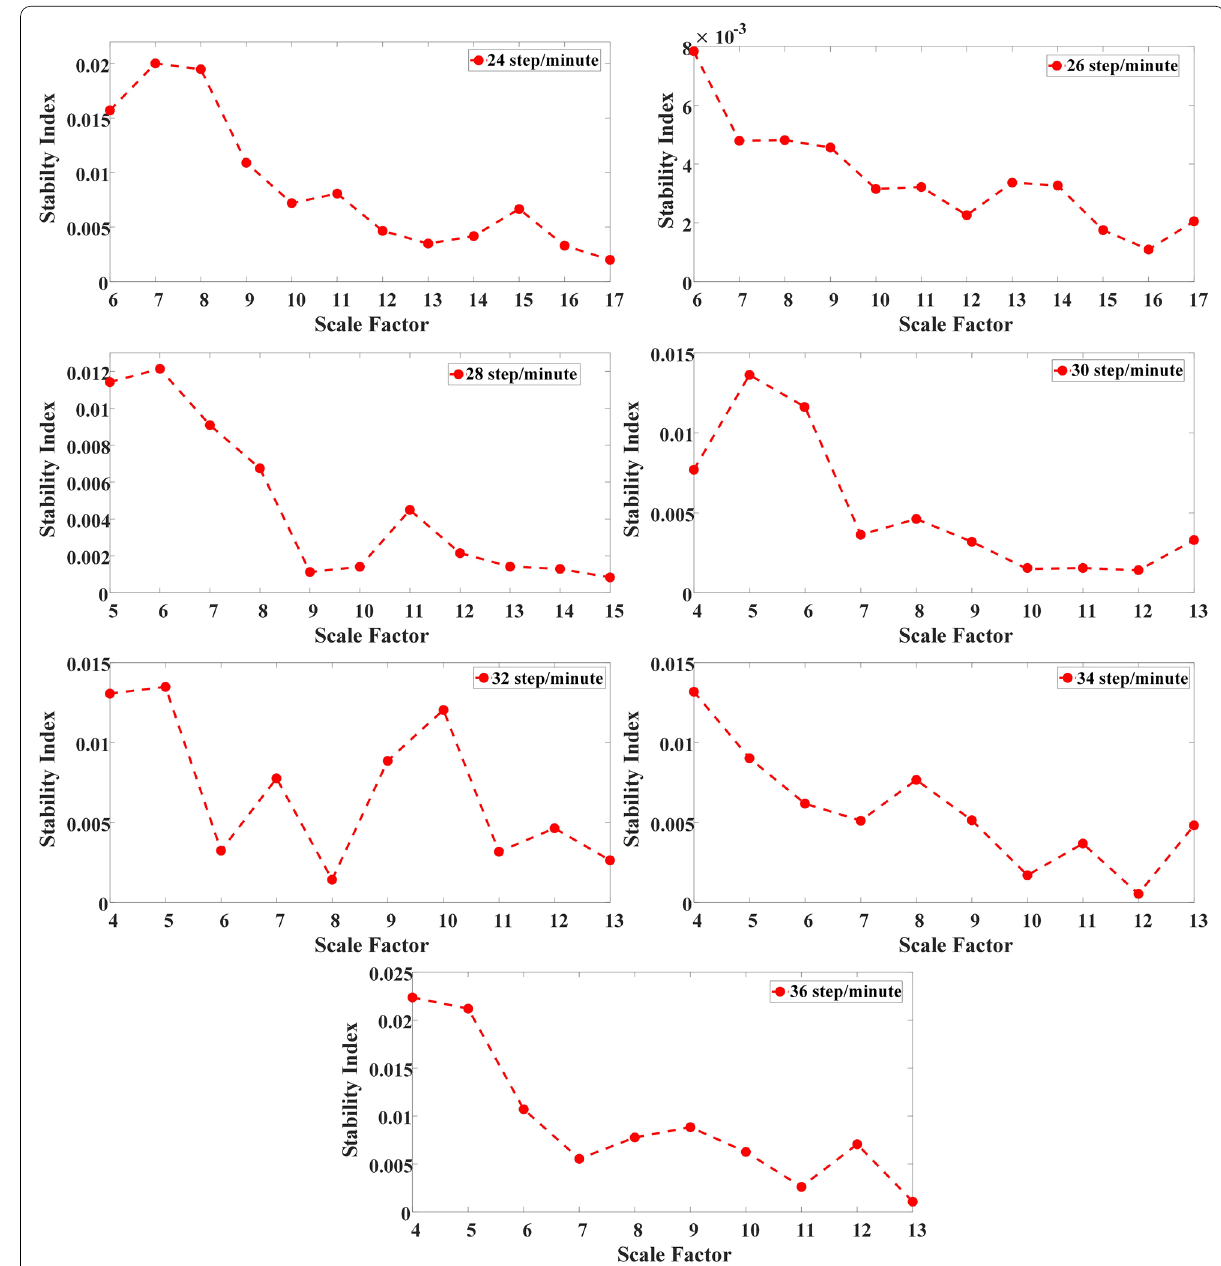
Figure 6 Stability index of the admittance control by statistical experiment